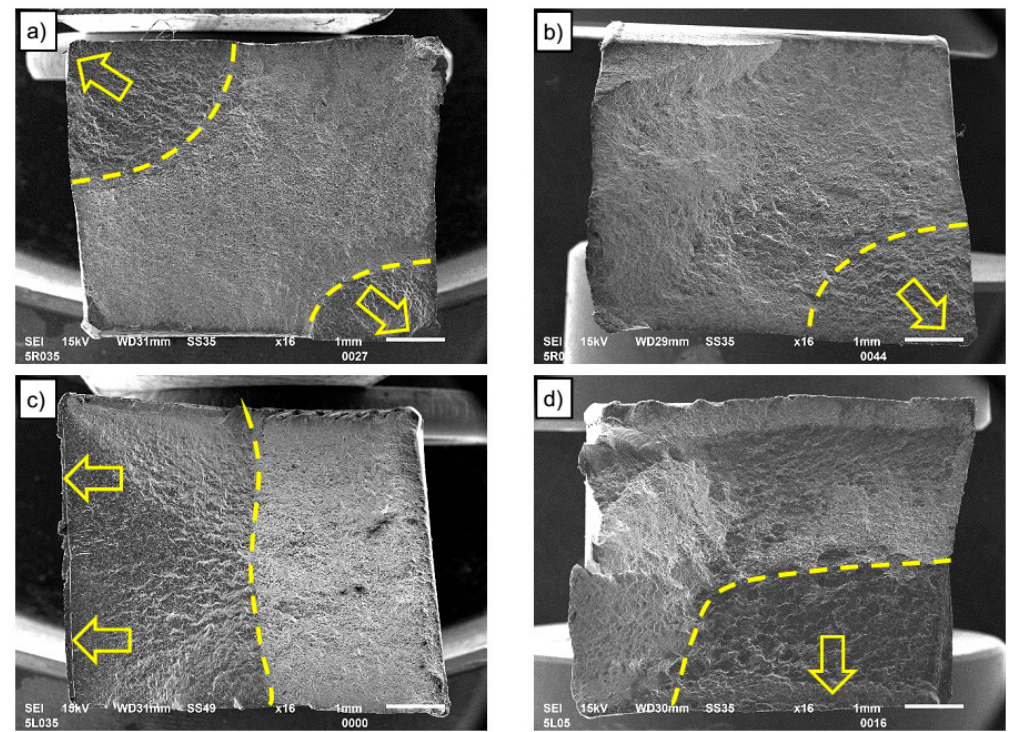
Figure 11. Example morphologies of fracture surfaces of base material ( a ) ε ac = 0.35%, ( b ) ε ac = 0.5%) and FSW joints ( c ) ε ac = 0.35%, and ( d ) ε ac = 0.5%).